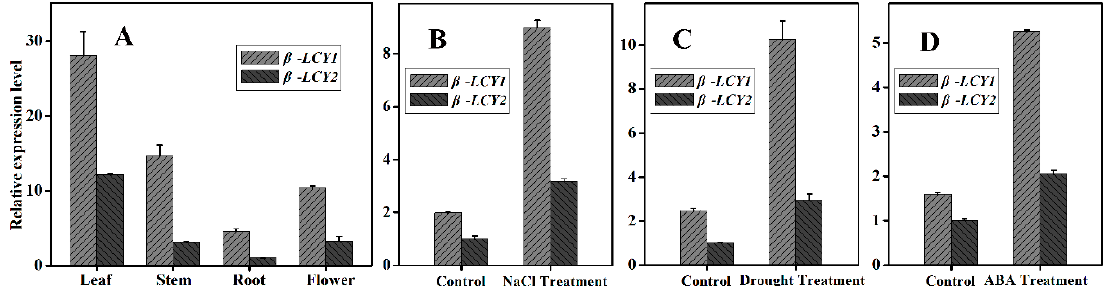
Figure 3. Nt β -LCY expression. ( A ) Spatiotemporal expression of Nt β -LCY in tobacco leaf, stem, root, and flower; ( B , C ) Relative expression levels of Nt β -LCY following salt and drought stress, as compared with untreated control plants (control); ( D ) Relative expression level of Nt β -LCY following ABA treatment. Error bars represent standard deviation ( n = 3). The data presented here are representative of three independent experiments.